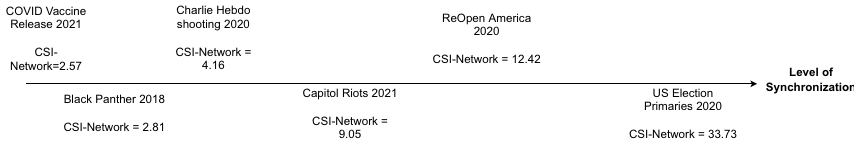
Fig. 3 Level of synchronization. Events ordered by their level of synchronization, from least to